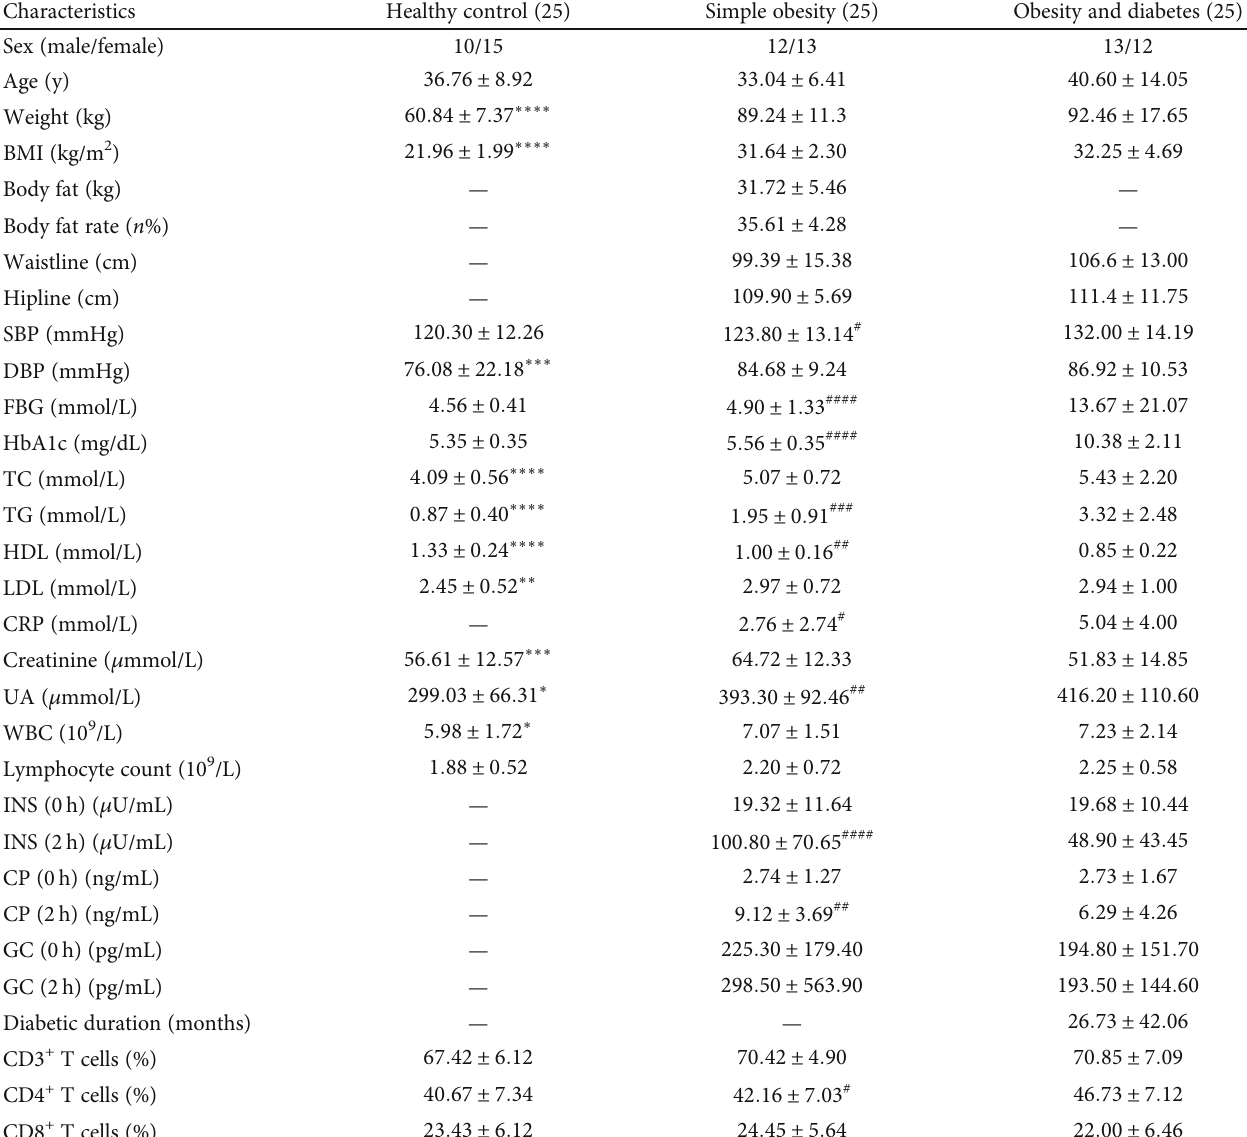
Table 1: Clinical and biochemical characteristics of the